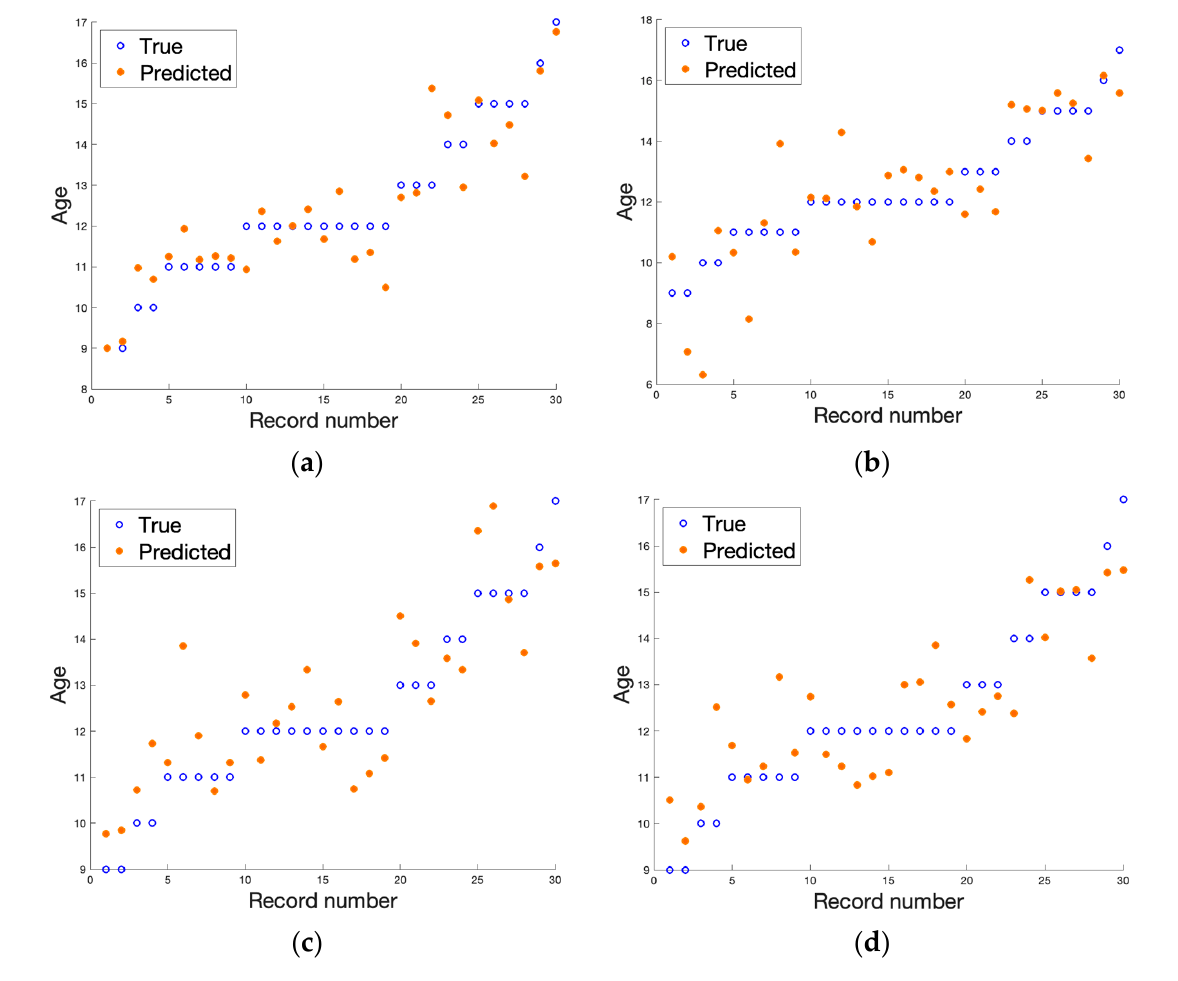
Figure 4. The result of regression algorithms for all examined cases for data describing growth region images (metric). The real age is given as a blue circle and age estimated with a regression algorithm is depicted as orange dot. The samples are ordered on the y axis with increasing age. ( a ) DICOM T1-weighted, ( b ) DICOM T2-weighted, ( c ) PNG T1-weighted, and ( d ) PNG T2-weighted.